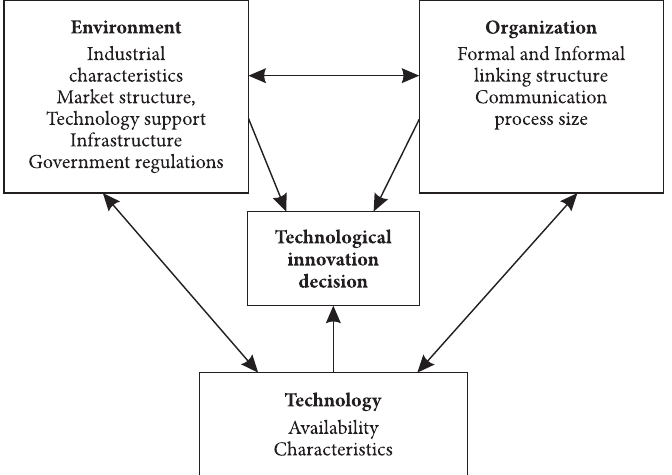
Figure 2. The technology-organization-environment framework (source: Tornatzky & Fleischer,